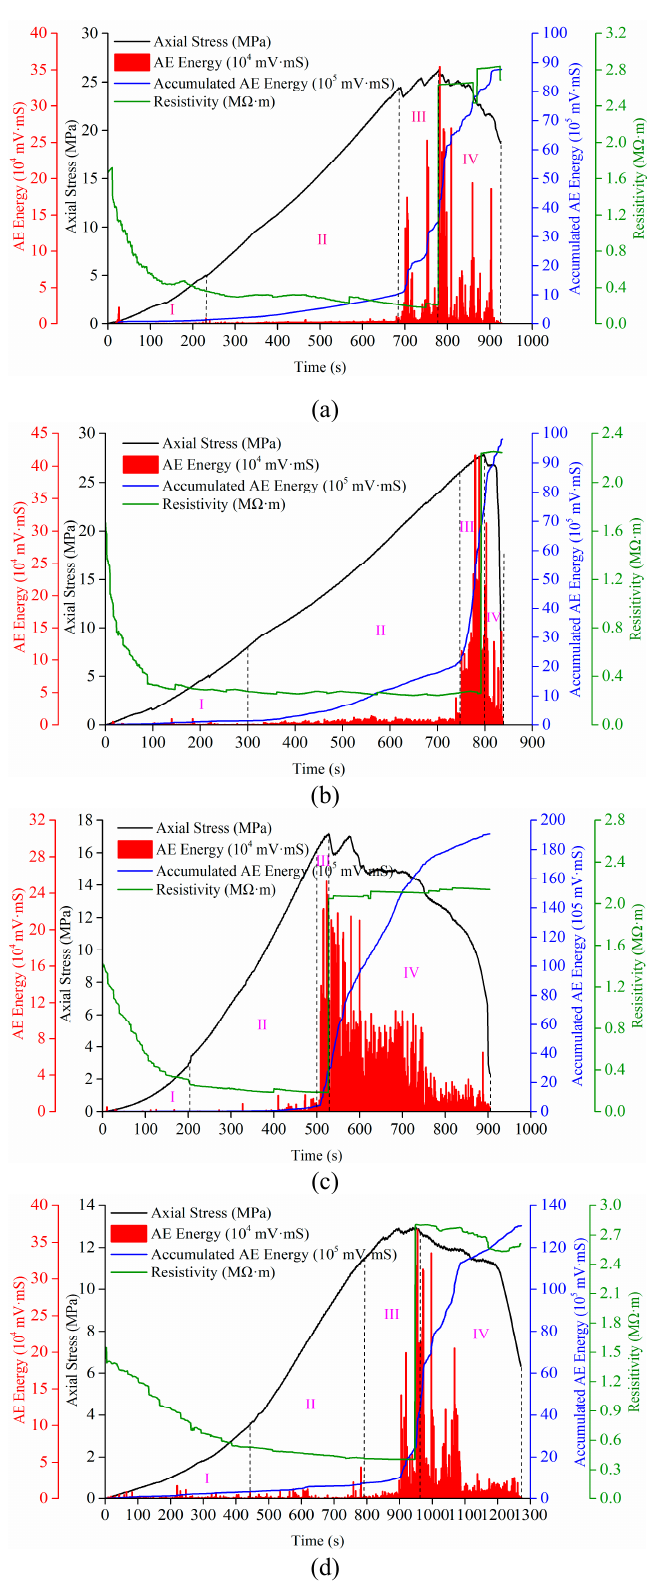
Figure 6. Developments of the axial stress, AE energy, accumulated AE energy, and resistivity for a sandwiched coal-rock system at different loading times. a C-R; b R-C; c R-C-R; d R-C-R-C-R.